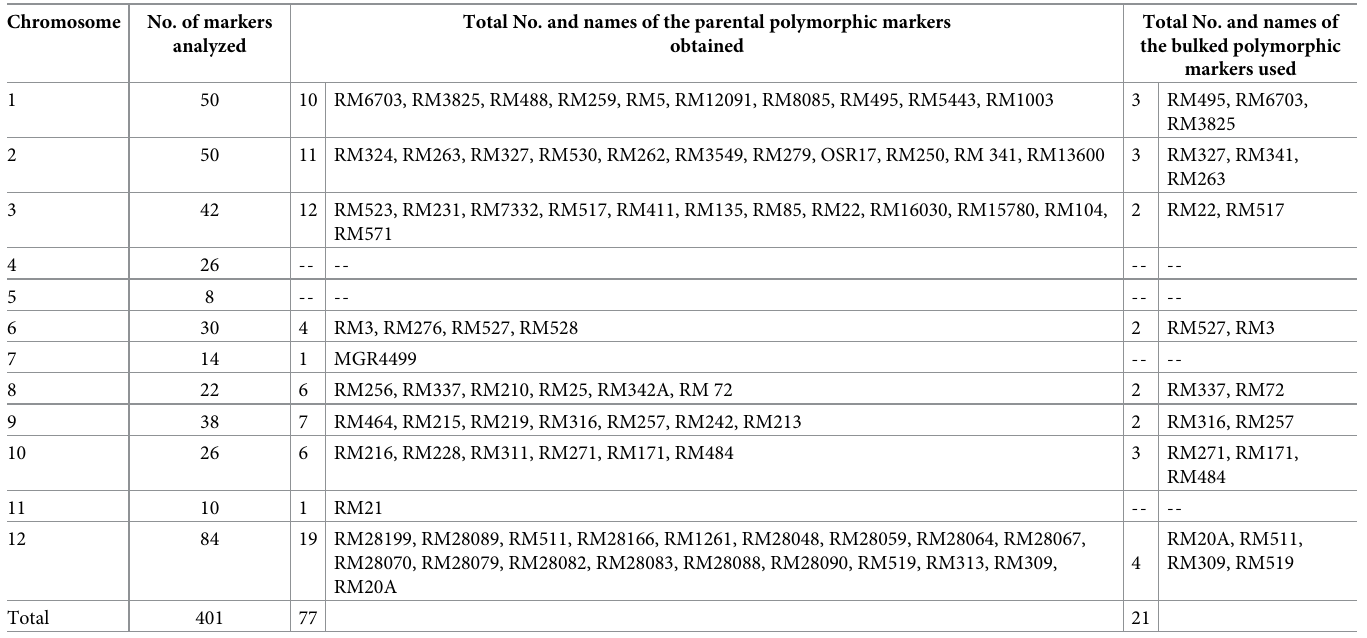
Table 1. Microsatellite markers obtained through the polymorphic analysis between CR143-2-2 and Krishnahamsa. Chromosome